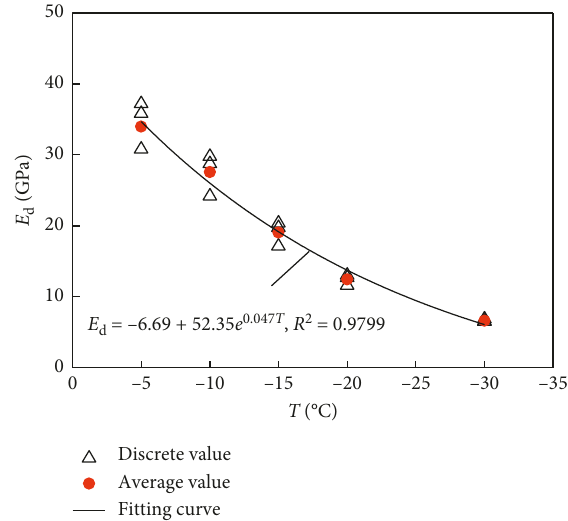
Figure 11: Relationship between dynamic elastic modulus ( E